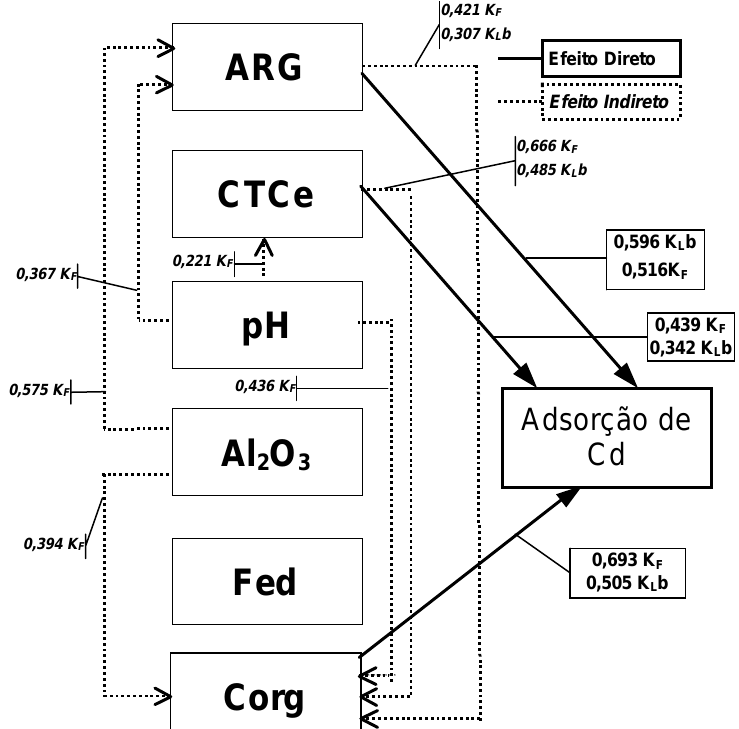
Figura 4. Diagrama explicativo com os valores dos efeitos diretos e indiretos obtidos da análise de trilha para as constantes Freundlich (K ) e capacidade-tampão máxima (K F CTCe, pH, ARG, Al O e Fed para amostras superficiais. 2 3